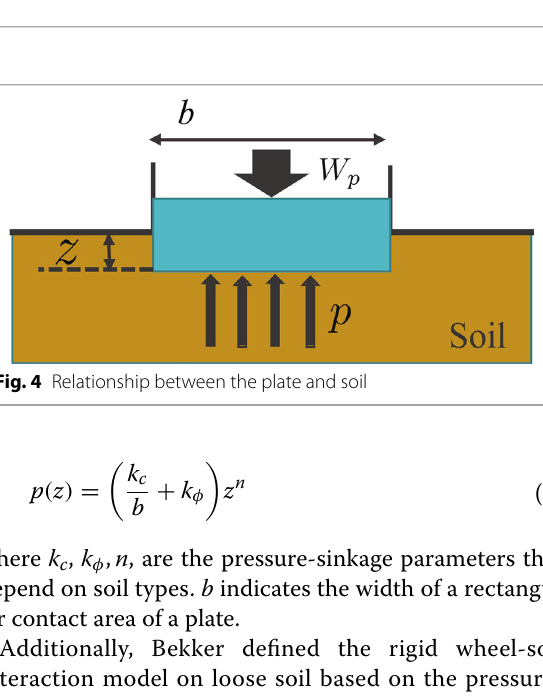
the pressure-sinkage relationship of a plate as shown in Fig. 4. According to Bekker [12], the normal stress p ( z ) acts on a plate when a plate sinks into loose soil as shown in Eq. (2).